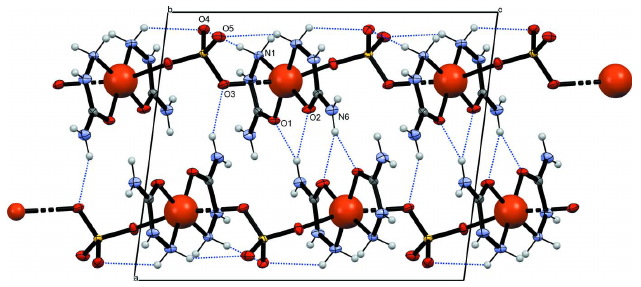
Figure 3 The crystal structure of the title compound. Intermolecular hydrogen bonds are indicated by dashed